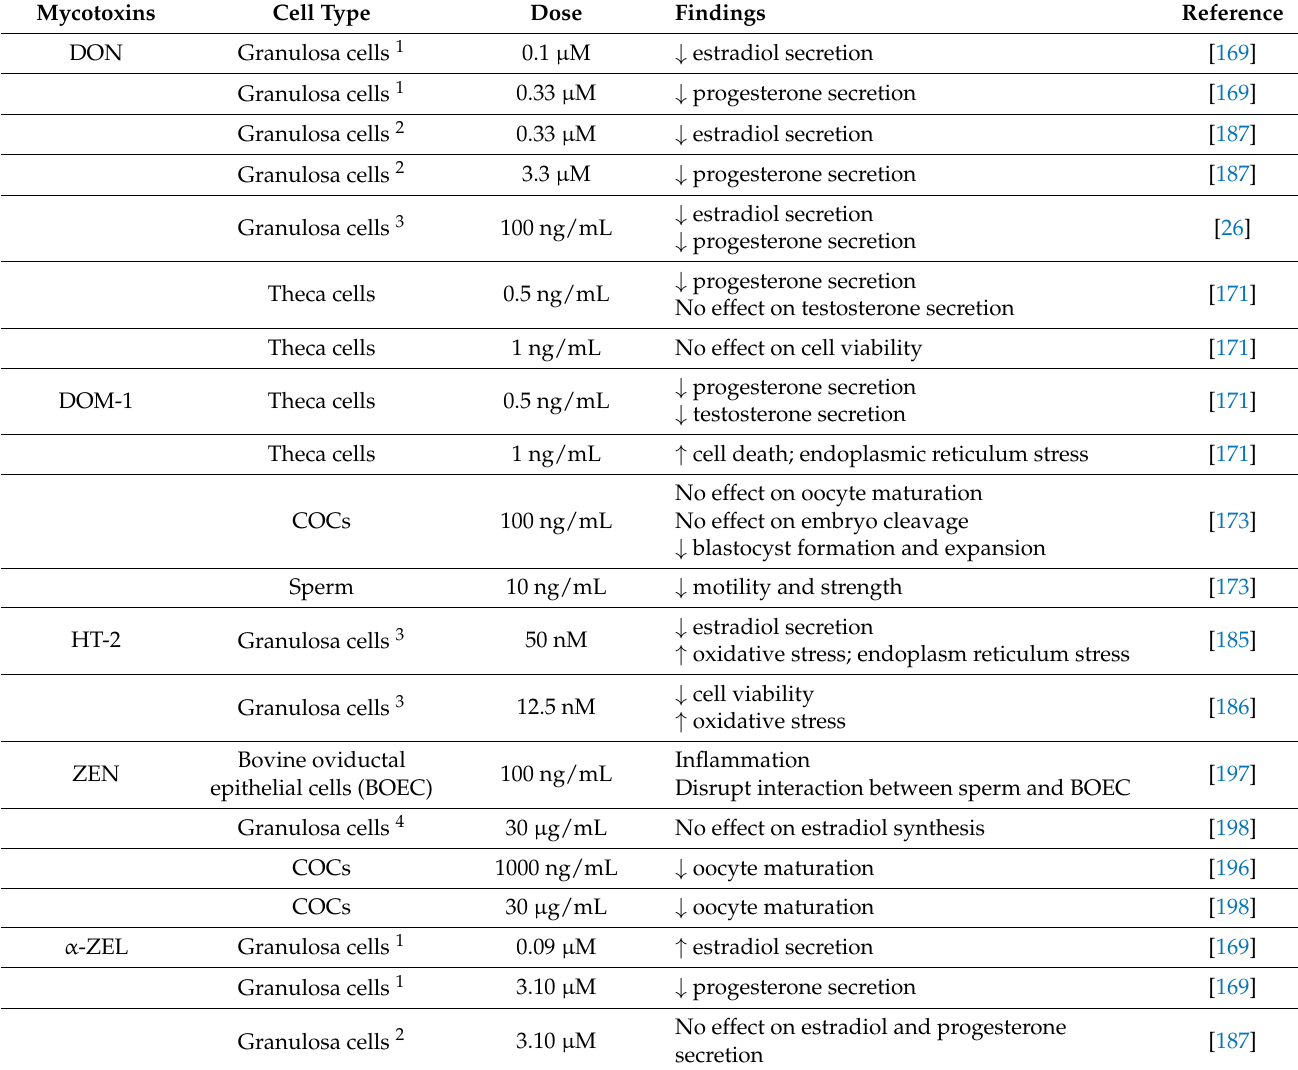
Table 4. Effects of Fusarium toxins on livestock reproductive function ( in vitro studies with bovine cells). Mycotoxins Findings